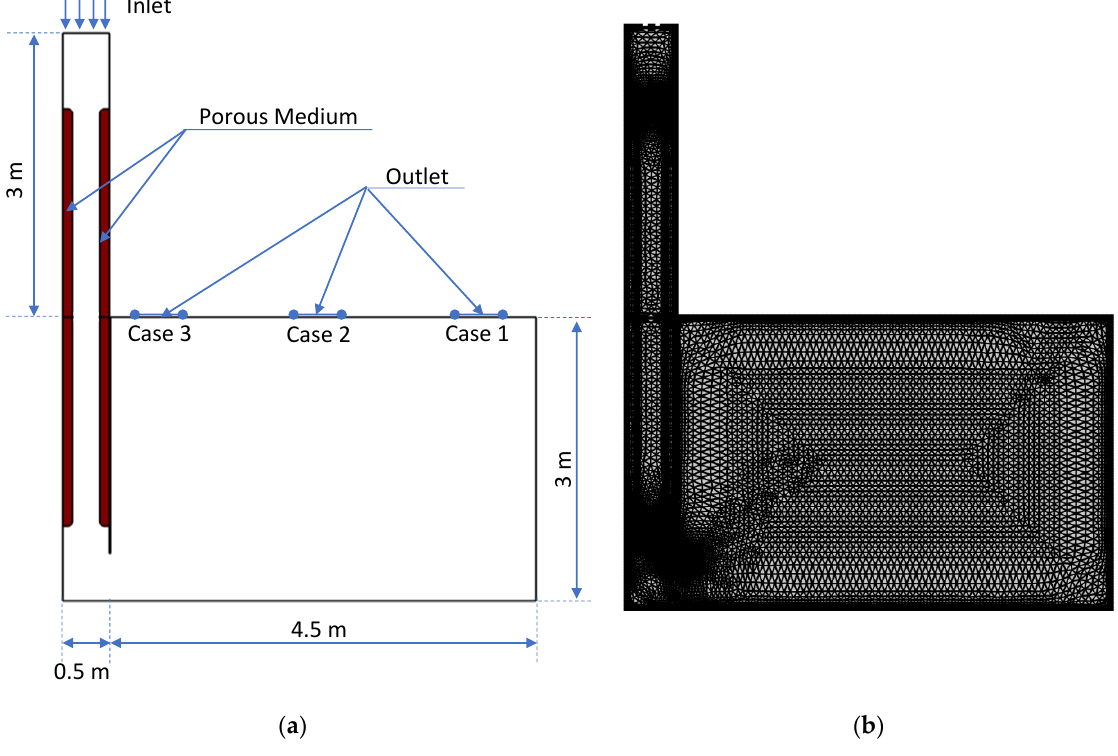
Figure 1. ( a ) Studied configuration and ( b ) used mesh.